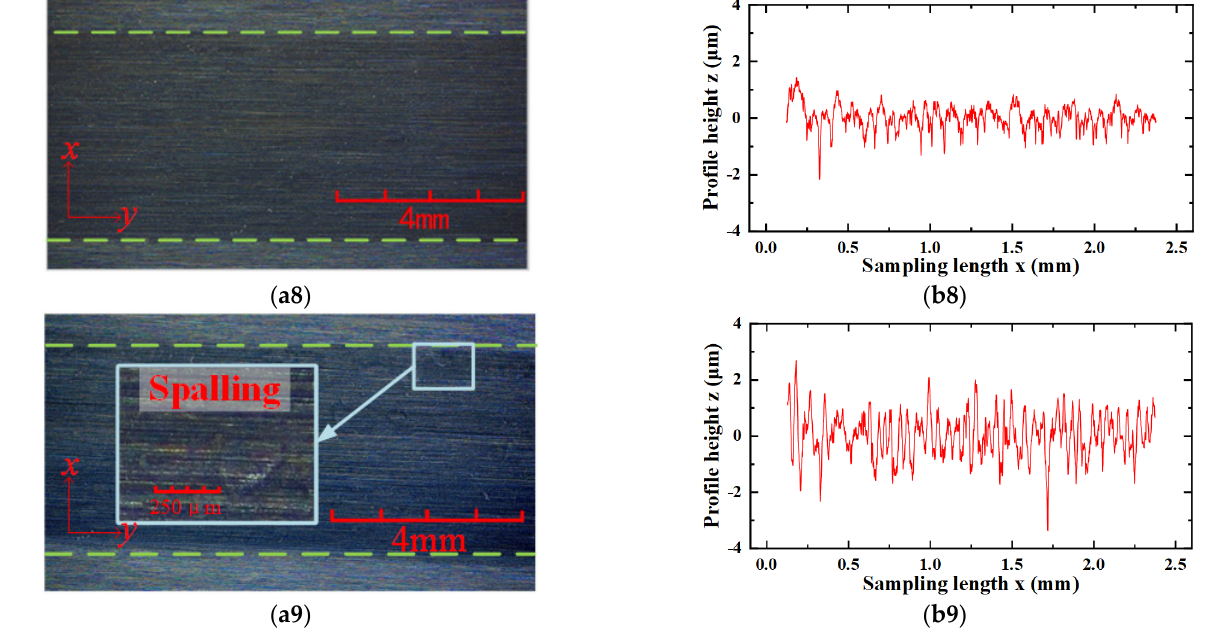
Figure 9. Microscopic pictures and two-dimensional contours of the rail raceway surface. ( a1 ) and ( b1 ) 0 km, ( a2 ) and ( b2 ) 5 km, ( a3 ) and ( b3 ) 10 km, ( a4 ) and ( b4 ) 15 km, ( a5 ) and ( b5 ) 20 km, ( a6 ) and ( b6 ) 25 km, ( a7 ) and ( b7 ) 30 km, ( a8 ) and ( b8 ) 40 km, ( a9 ) and ( b9 ) 50 km.